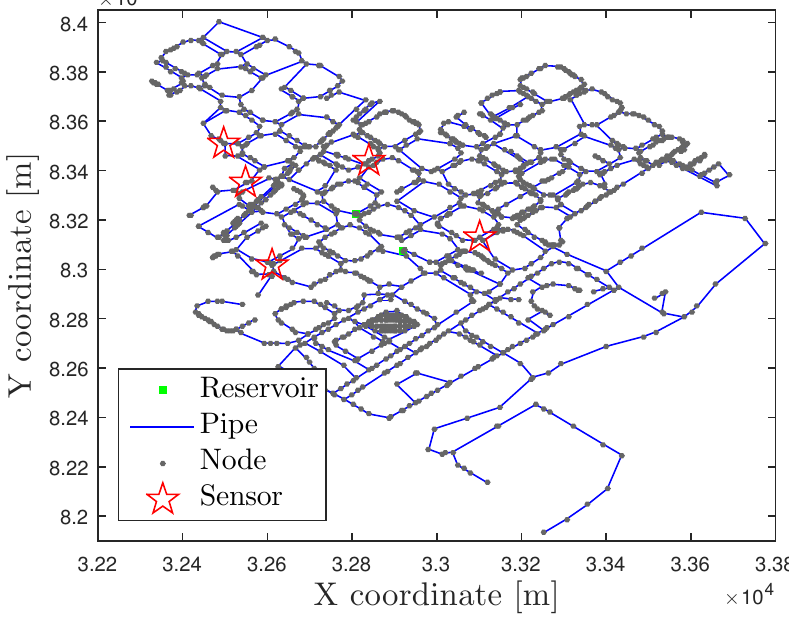
Figure 8. Nova Icària DMA topological